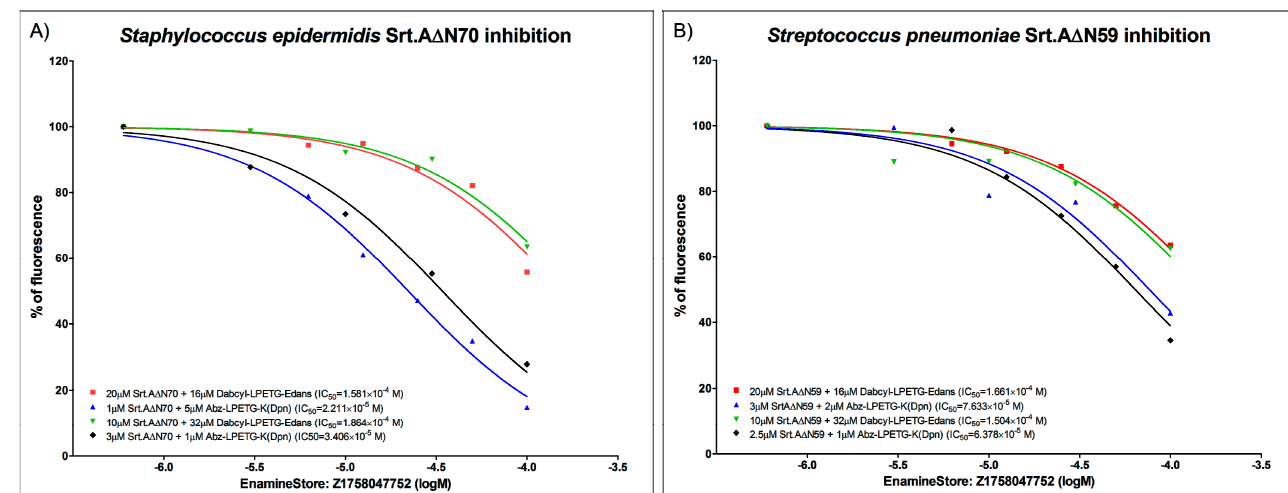
Figure 2. Enzyme inhibition curves for ( A ) recombinant Δ 70 Staphylococcus epidermidis SrtA, and ( B ) recombinant Δ 59 Streptococcus pneumoniae SrtA. N-terminal parts containing membrane anchor domain were cleaved to improve solubility and purification of enzyme. FRET-based inhibition assays were carried out employing two different substrates: Abz- LPETG-K (Dnp), Dabcyl-LPETG-Edans, one lead compound, Z1758047752, which was acquired from Enamine Ltd. (https://www.enaminestore.com/). Measurements were performed in triplicates and repeated twice. Results demonstrate that acquired IC 50 values are substrate dependent.